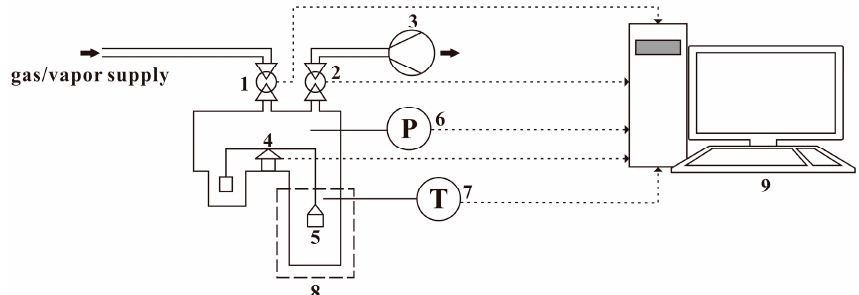
Figure 2. Schematic diagram of IGA. (1, admit valve; 2, exhaust valve; 3, vacuum pump; 4, micro-balance; 5, sample basket; 6, pressure transducer; 7, temperature transducer; 8, thermostat; 9, data system).